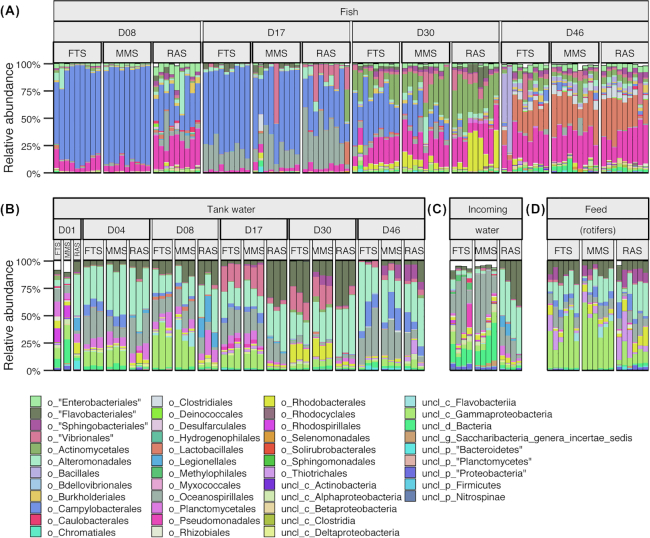
Relative abundances of the 45 most abundant bacterial orders detected in (A) fish, (B) tank water, (C) incoming water and (D) feed samples in the systems FTS, MMS and RAS; D01-D46 indicates sampling times given as dph.